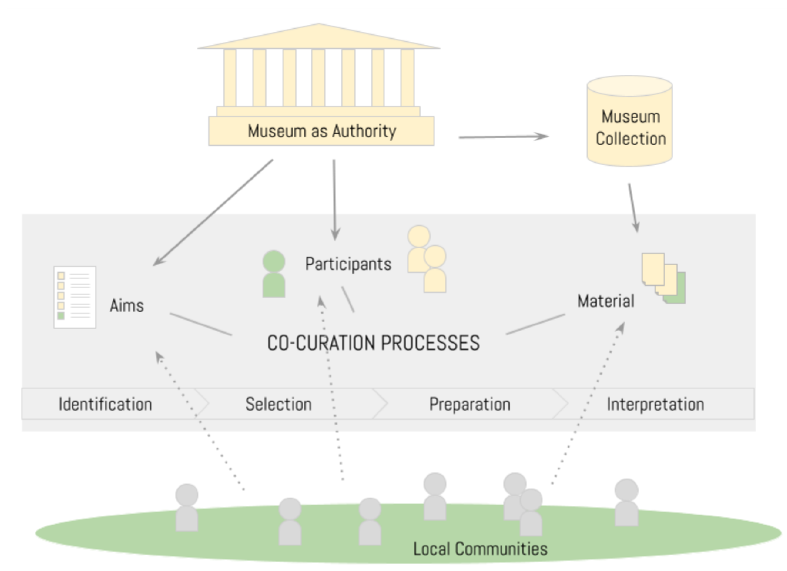
Figure 5. Imbalances in co-curation